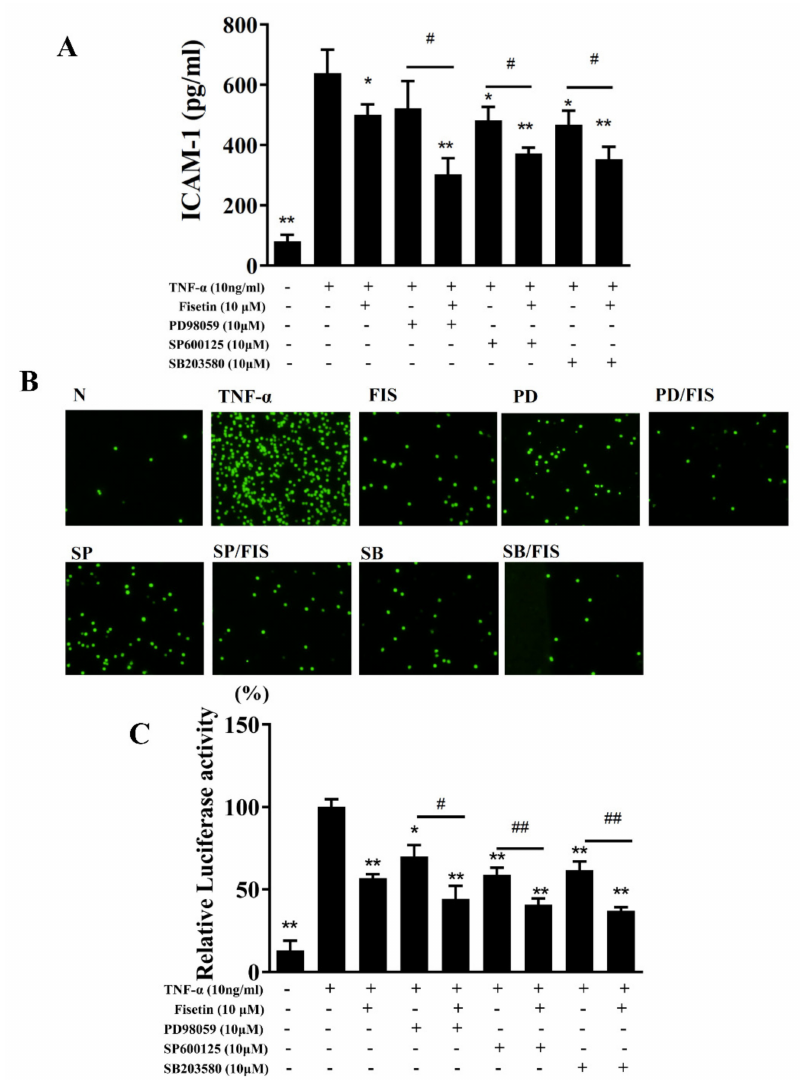
Figure 6. ICAM-1 expression suppressed by treatment with fisetin (Fis) and MAPK inhibitors in TNF- α -induced BEAS-2B cells. ( A ) ICAM-1 levels detected by ELISA. ( B ) THP-1 cells (fluorescently labeled green) co-cultured with unstimulated (N) or TNF- α –stimulated BEAS-2B cells treated with Fis and MAPK inhibitors. ( C ) Fisetin and MAPK inhibitors decreased luciferase activity as determined by the NF- κ B promoter assay. The data are presented as mean ± SEM of three independent experiments. * p < 0.05, ** p < 0.01, compared to the TNF- α -stimulated BEAS-2B cell control. # p < 0.05, ## p < 0.01, compared to MAPK inhibitor-treated TNF- α -activated BEAS-2B cells. N: untreated cells; TNF- α : TNF- α -activated BEAS-2B cells; Fis: 10 µ M fisetin treated with TNF- α -activated BEAS-2B cells; PD: PD98059 treated with TNF- α -activated BEAS-2B cells; PD/Fis: PD98059 and 10 µ M fisetin treated with TNF- α -activated BEAS-2B cells; SP: SP600125 treated with TNF- α -activated BEAS-2B cells;